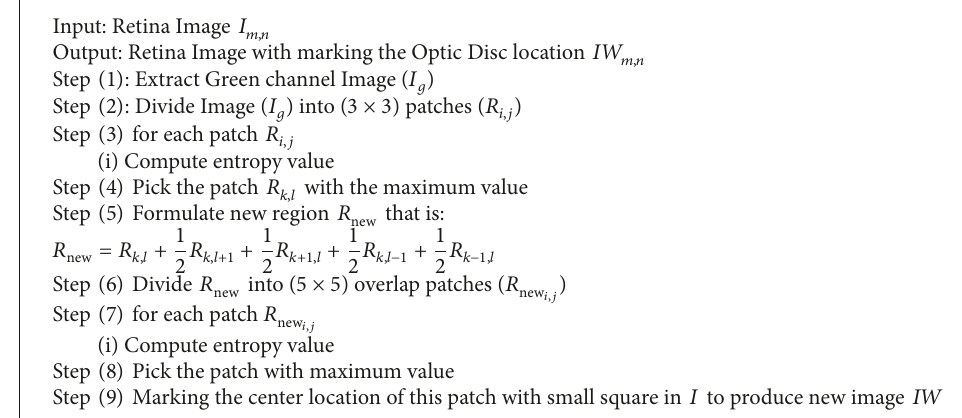
Algorithm 1: Proposed algorithm: localization of optic disk.